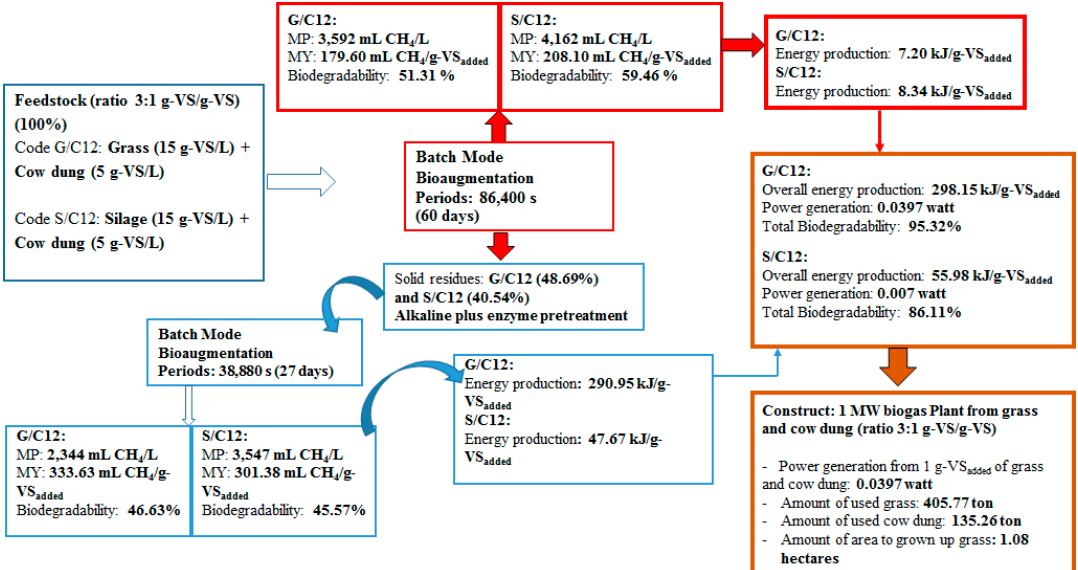
Figure 7. Energy production, power generation, biodegradation efficiency and the amount of grass and cow dung for constructing 1 MW biogas from co-digestion of grass with cow dung at the mixing ratio of 3:1. G/C12: Co-digestion of grass with cow dung at the ratio of 3:1 g-VS/g-VS, S/C12: Co-digestion of silage with cow dung at the ratio of 3:1 g-VS/g-VS, MP: Methane production (mL CH 4 /L); MY: Methane yield (mL CH 4 /g-VS added ).